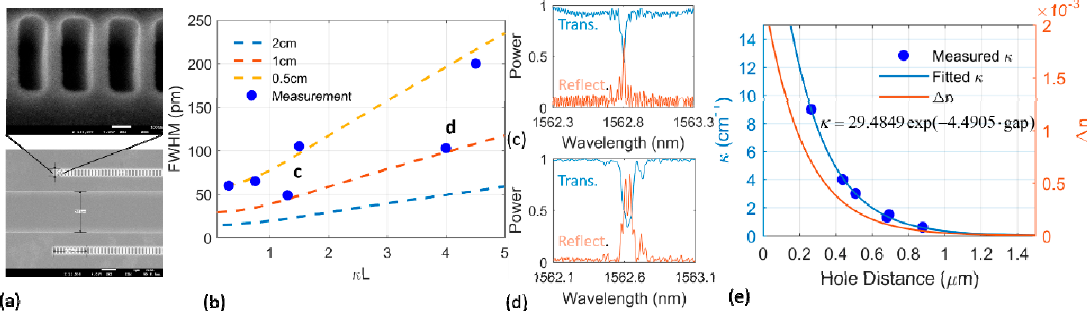
Figure 6. ( a ) An SEM image of the fabricated low κ Bragg grating waveguide with a close-up of the holes on both sides of the waveguide. ( b ) Theoretical calculations of gratings’ full width half max (FWHM) versus varying κ L for 0.5, 1 and 2 cm long grating waveguides. Circular blue markers show the measured data. ( c , d ) Spectra of reflection and transmission of 1 cm long grating waveguides with κ = 1.25 cm − 1 and κ = 4.0 cm − 1 , respectively. The ripples are caused by reflections off the waveguide facets. ( e ) The extracted κ , ∆ n , and exponential fit as a function of waveguide to hole distance.